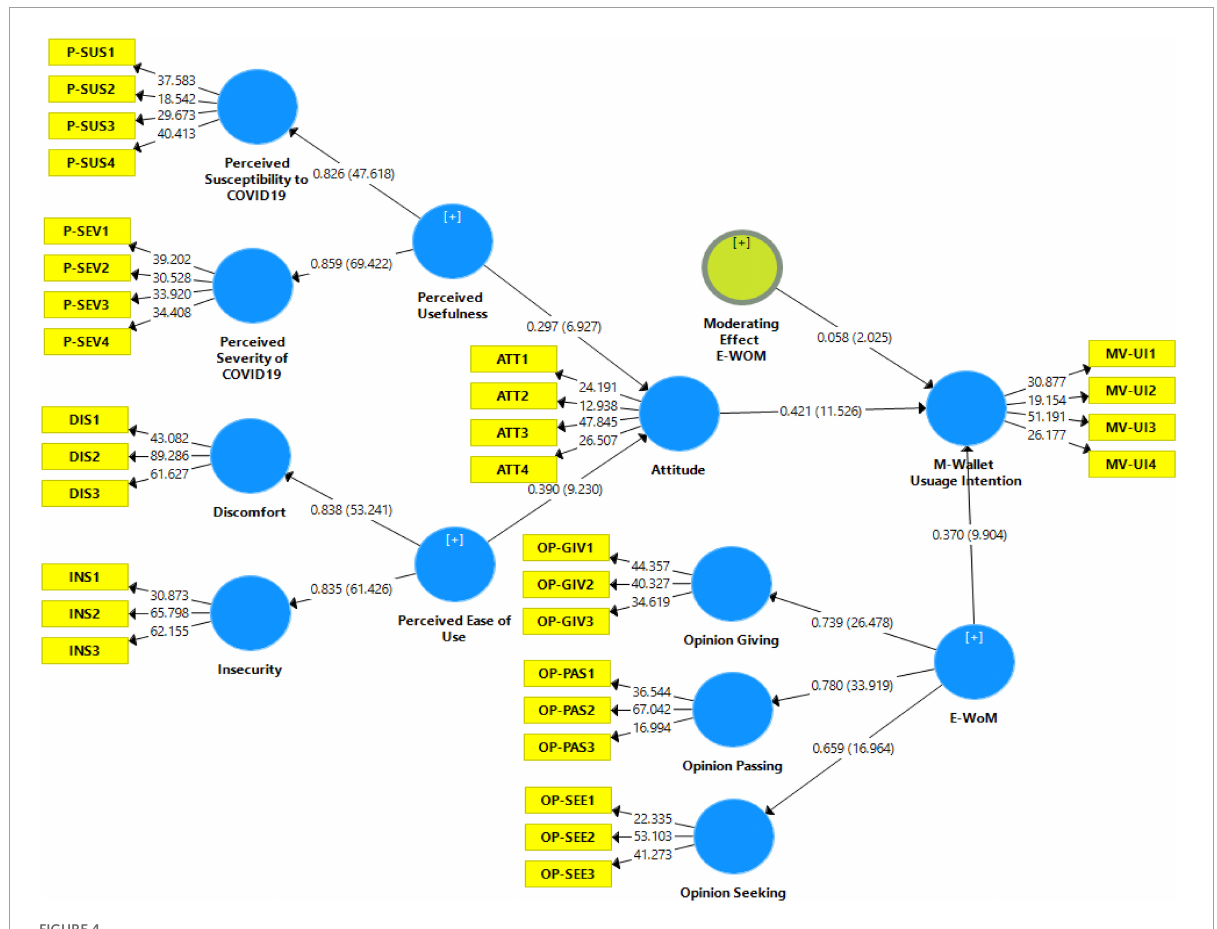
FIGURE4 Moderating effect –